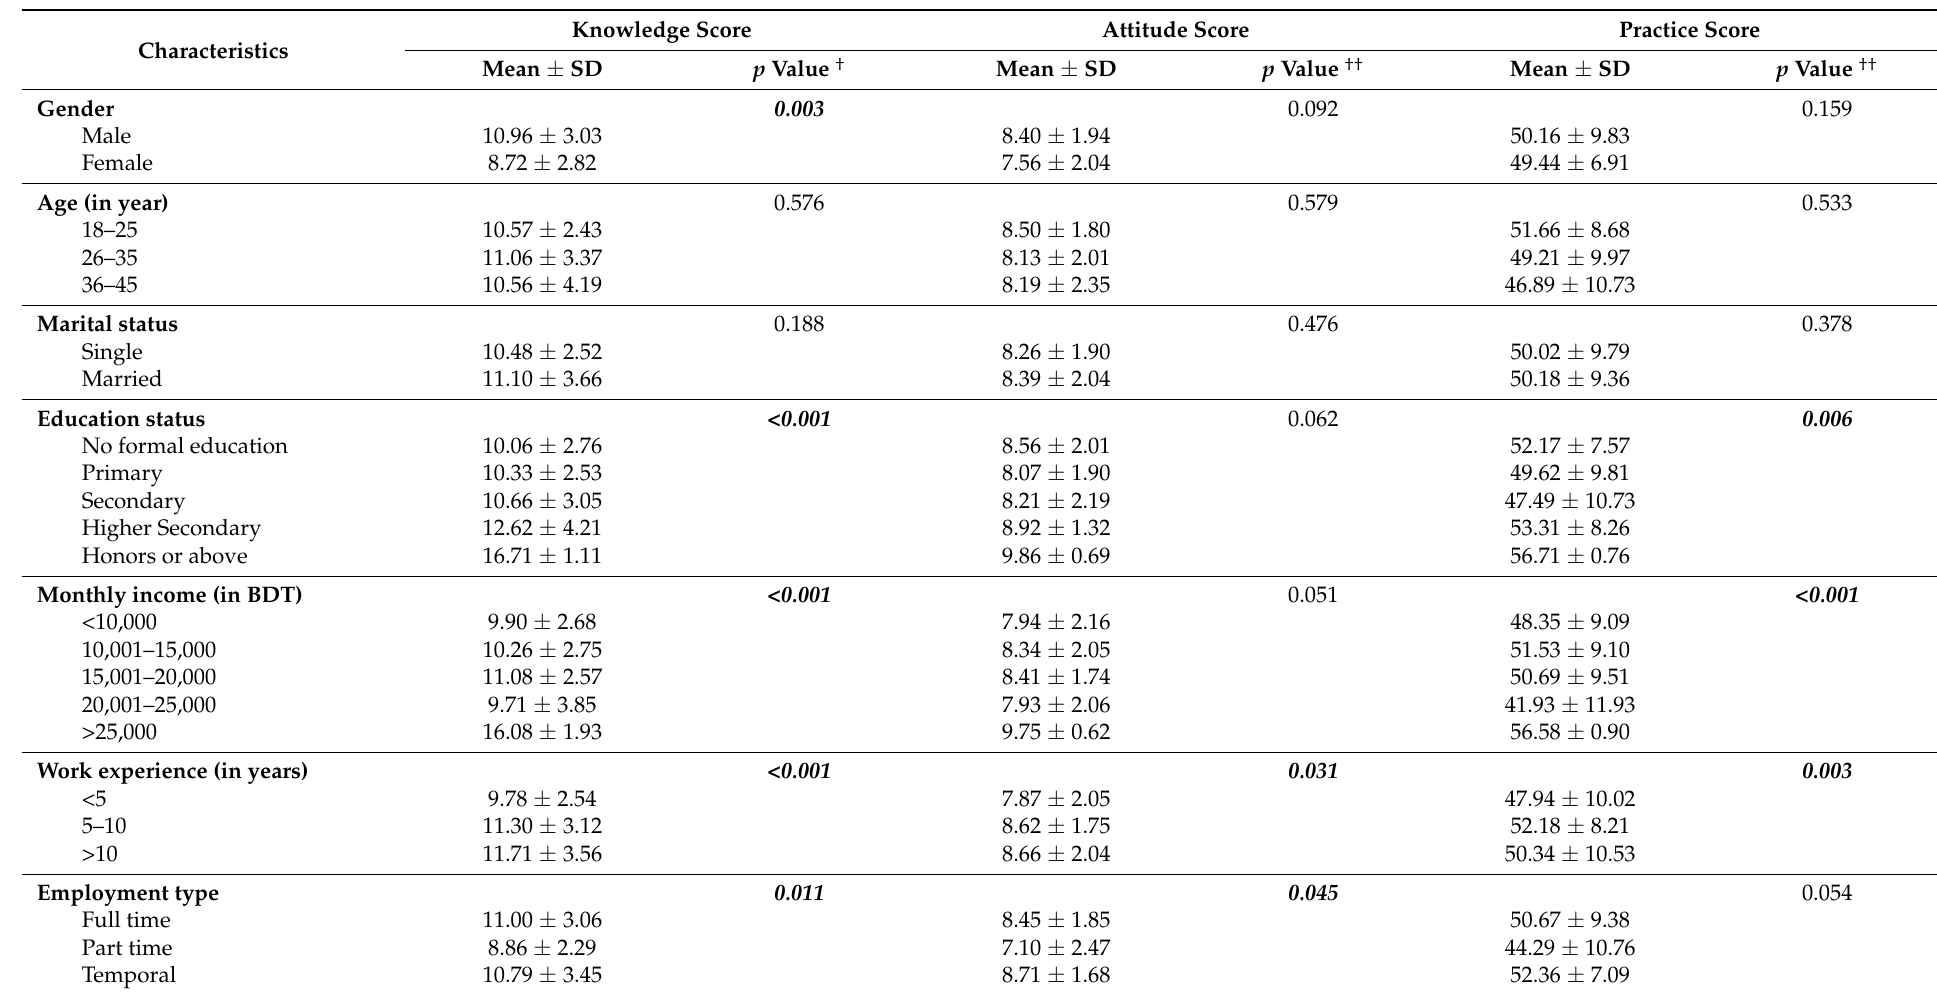
Table 5. Respondents’ food safety knowledge, attitudes and practices by their sociodemographic and employment characteristics (N =